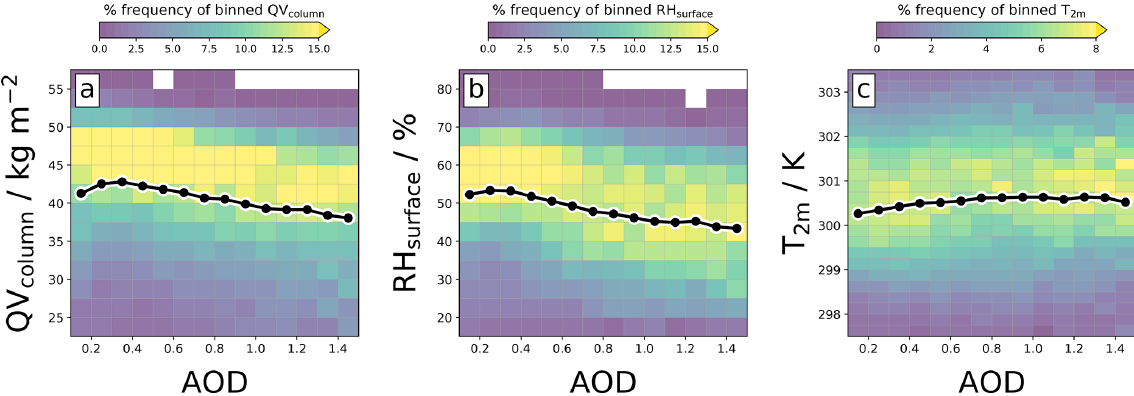
Figure 9. Daily mean (a) AIRS total column water vapour (QV column ), (b) AIRS surface RH (RH surface ), and (c) ERA5 2m temperature ( T 2m ) as a function of AOD. Joint histograms show % the frequency of each variable binned by AOD, and black lines show the mean in each AOD